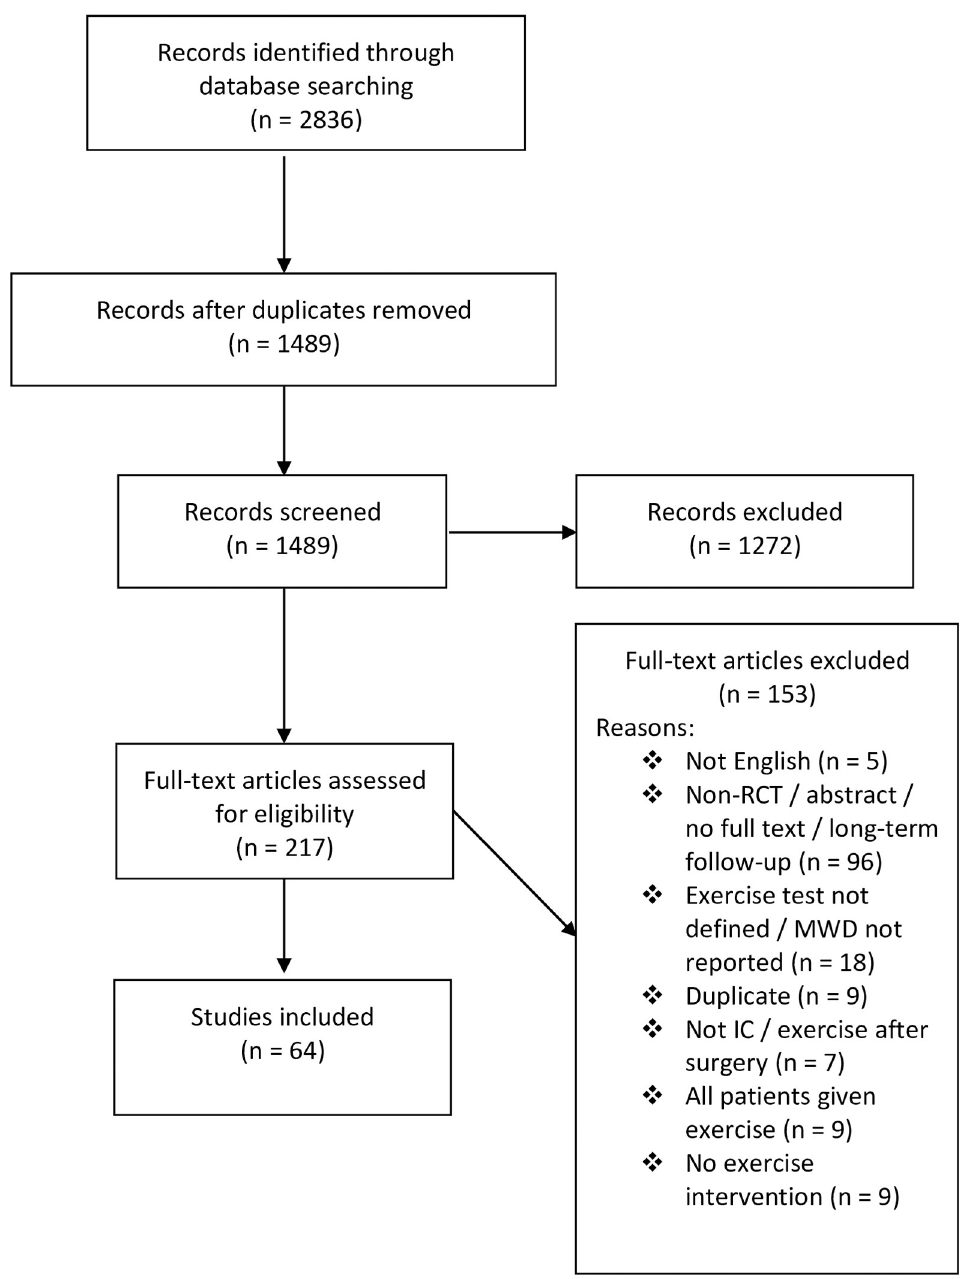
Fig 1. PRISMA flow chart for study identification. MWD, maximal walking distance; IC, intermittent claudication.